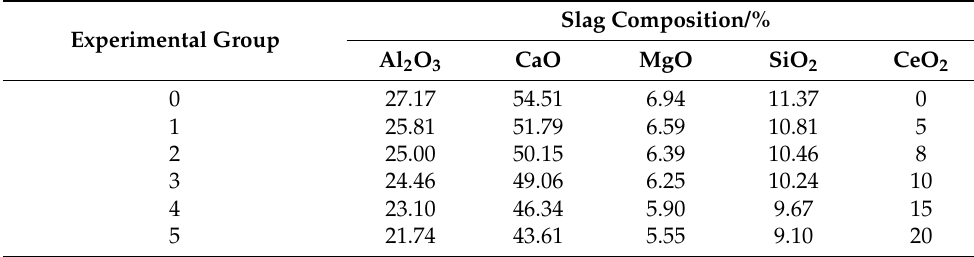
Table 2. Experimental slag-composition